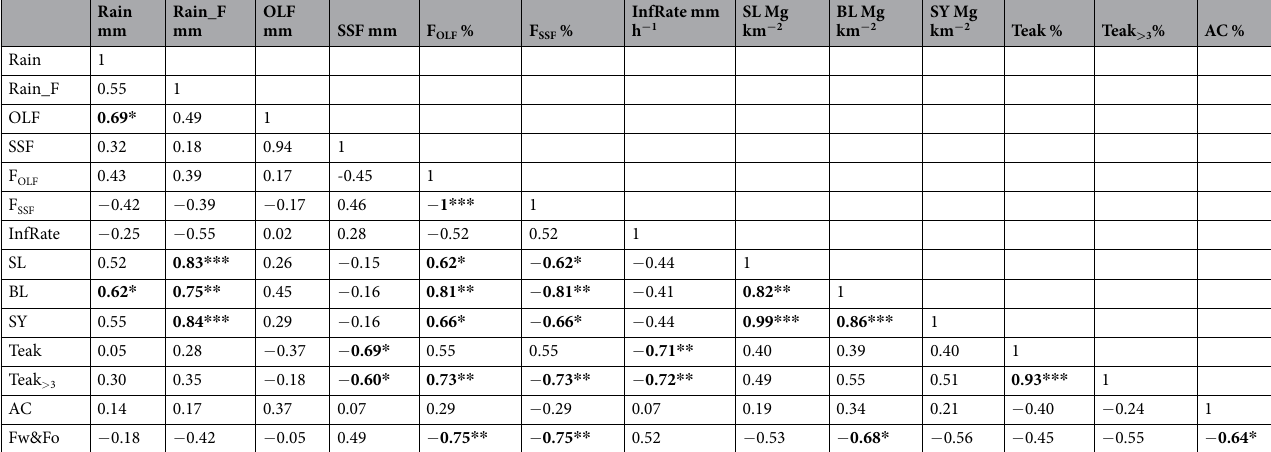
Table 1. Correlation matrix (Pearson correlation coefficients; * p -value < 0.05, ** p -value < 0.01, *** p - value < 0.001) between the following variables: annual rainfall depth (Rain); flood-triggering annual rainfall depth (Rain_F); annual overland flow depth (OLF); annual subsurface flow depth (SSF); annual median of overland flow contribution to total depth of each flood event (F OLF ); annual median of subsurface flow contribution to total depth of each flood event (F SSF ); annual median of event infiltration rates at the catchment